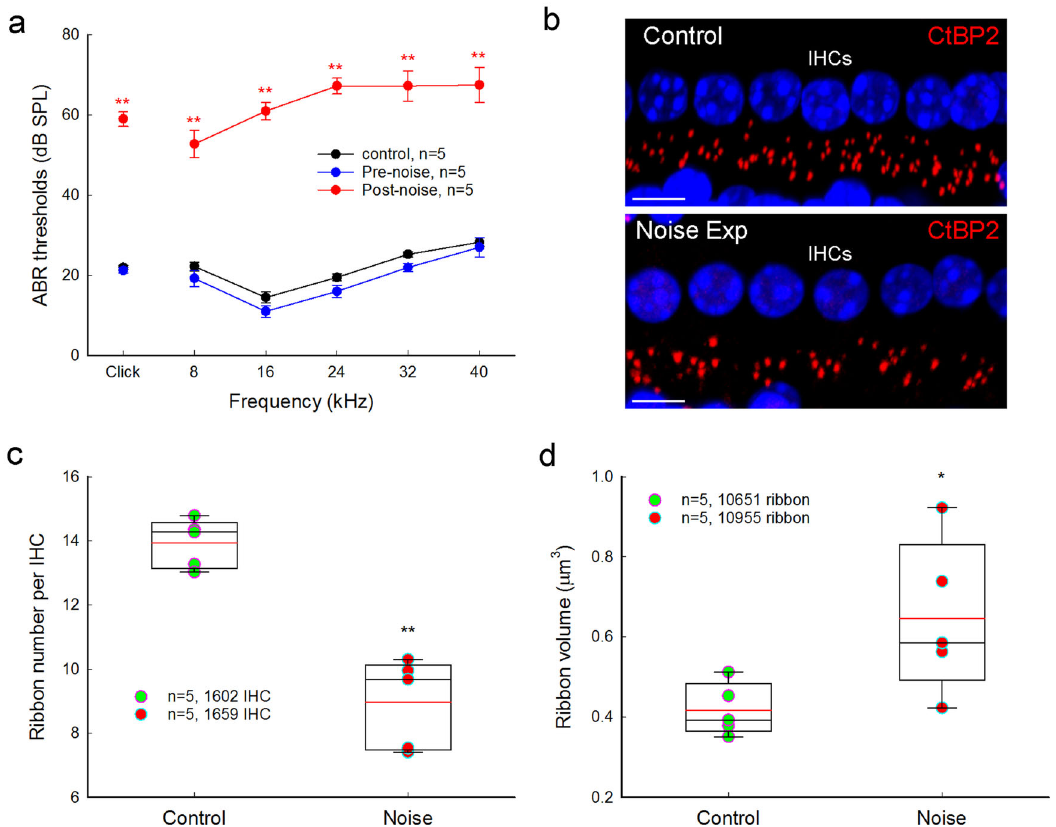
Fig. 8 ABR threshold elevation and ribbon synapse degeneration after noise exposure. Mice were exposed to 95 – 98 dB SPL white-noise for 2 h. After stop of noise exposure, ABR thresholds were immediately recorded and the inner ears were isolated after recording and fi xed for immuno fl uorescence staining. a Noise-induced ABR threshold elevation. After noise exposure, the ABR thresholds in the noise exposure mice were signi fi cantly increased about 45 – 55 dB SPL. N is the mouse number. b Immuno fl uorescent staining for CtBP2 at IHC area at the middle turn in noise exposure and control mice. Scale bar: 10 µ m. c IHC ribbon synapse degeneration after noise exposure. Red lines in the boxes represent the mean level. N is the mouse number. d IHC ribbon swelling after noise exposure. Red lines in the boxes represent the mean level. * P < 0.05; ** P < 0.01, one-way ANOVA with a Bonferroni correction for all